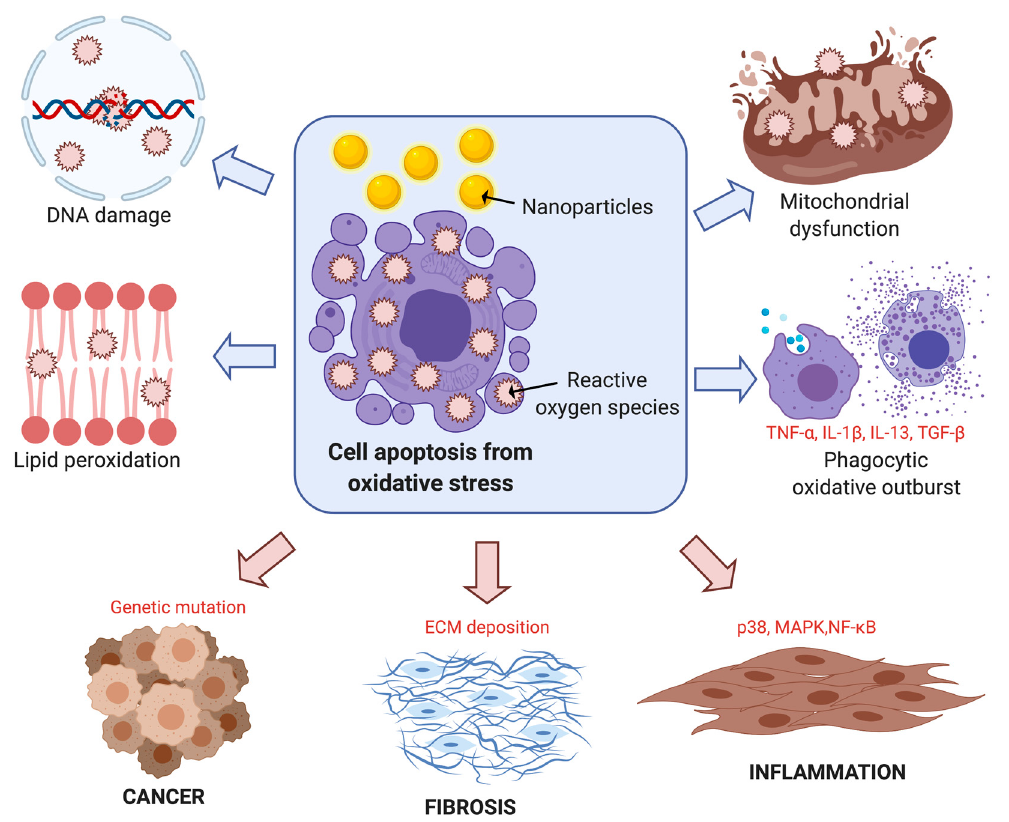
Figure 2. Prooxidant pathway for nanoparticle-induced toxicities. Upon nanoparticle exposure, ROS generation induces oxidative DNA damage, strand breaks, protein denaturation, and lipid peroxidation. Mitochondrial membrane damage results from excess free radical production, leading to necrosis and cell death. Phagocytes (i.e., neutrophils and macrophages) generate massive ROS upon incomplete phagocytosis of nanoparticle triggering an inflammatory cascade of chemokine and cytokine expression via activation of cell signaling pathways. Adapted from reference [154]. Created with BioRender.com.